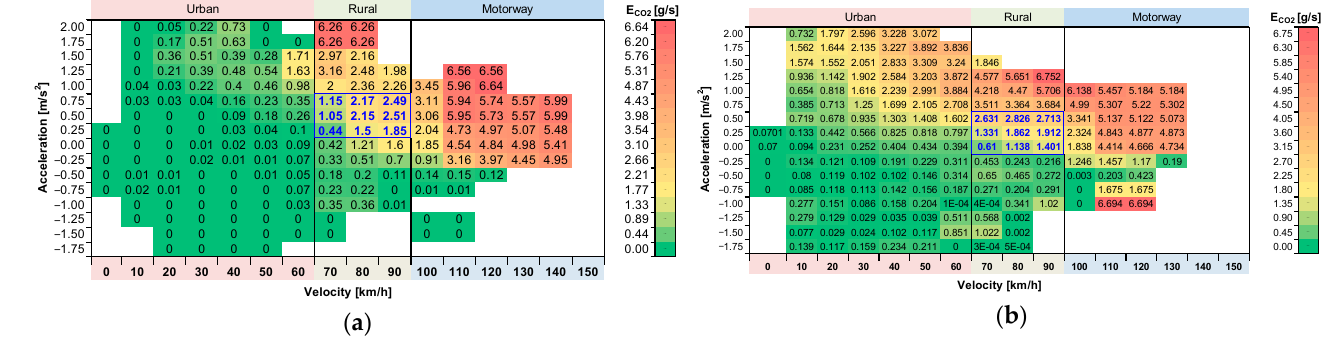
Figure 31. Carbon dioxide emission rate (E CO2 ) in the RDE test for: ( a ) plug-in; ( b ) HEV.